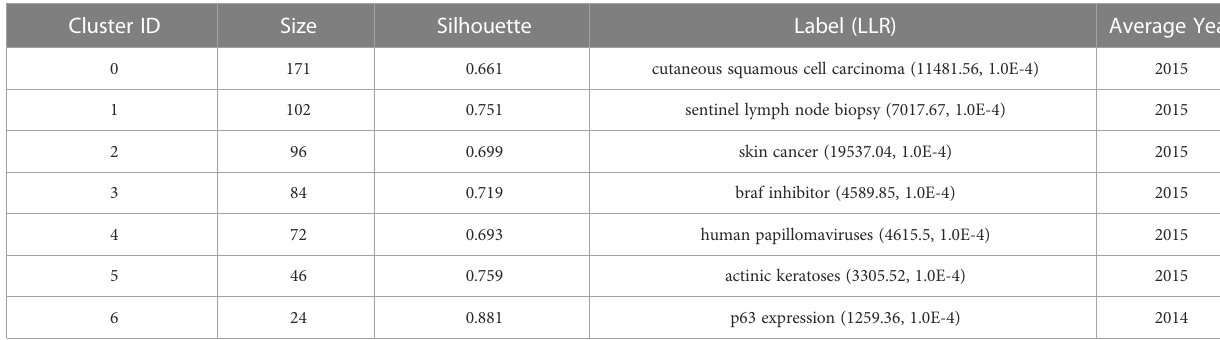
TABLE 6 Summary of the largest 7